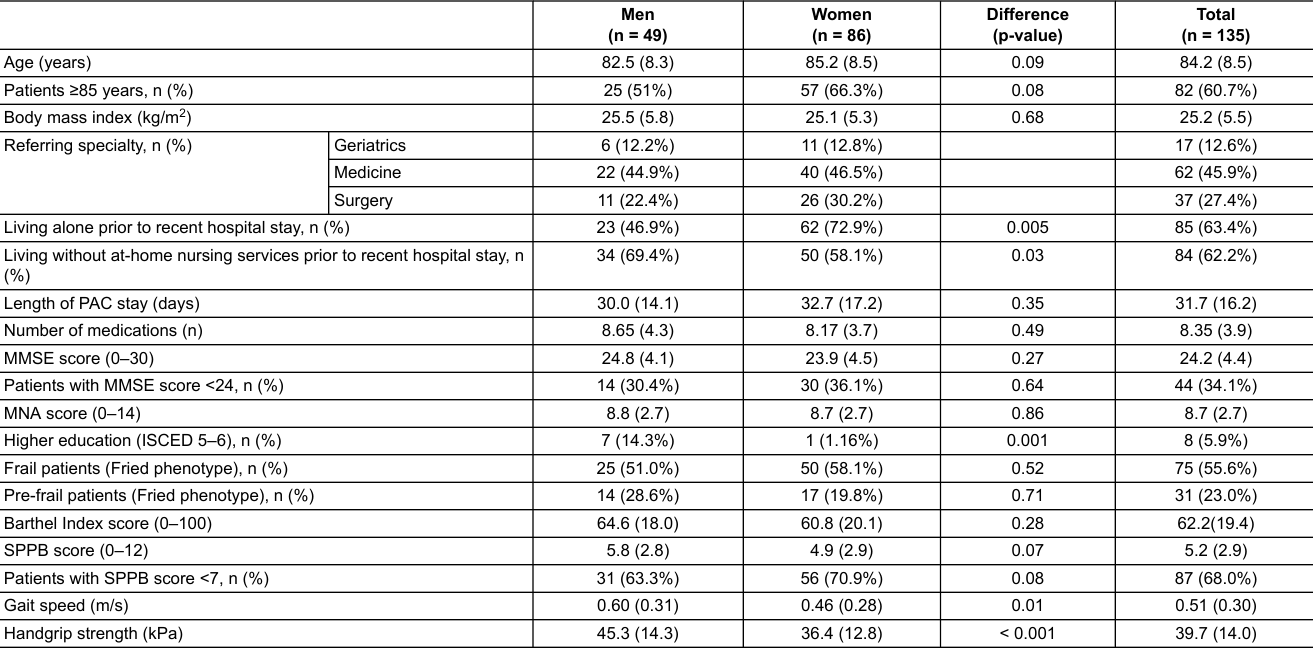
Table 1: Patient characteristics at admission to post-acute care.